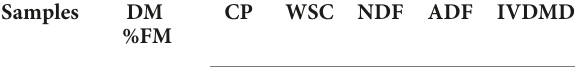
TABLE 3 The chemical compositions of fresh and ensiled paper mulberry.